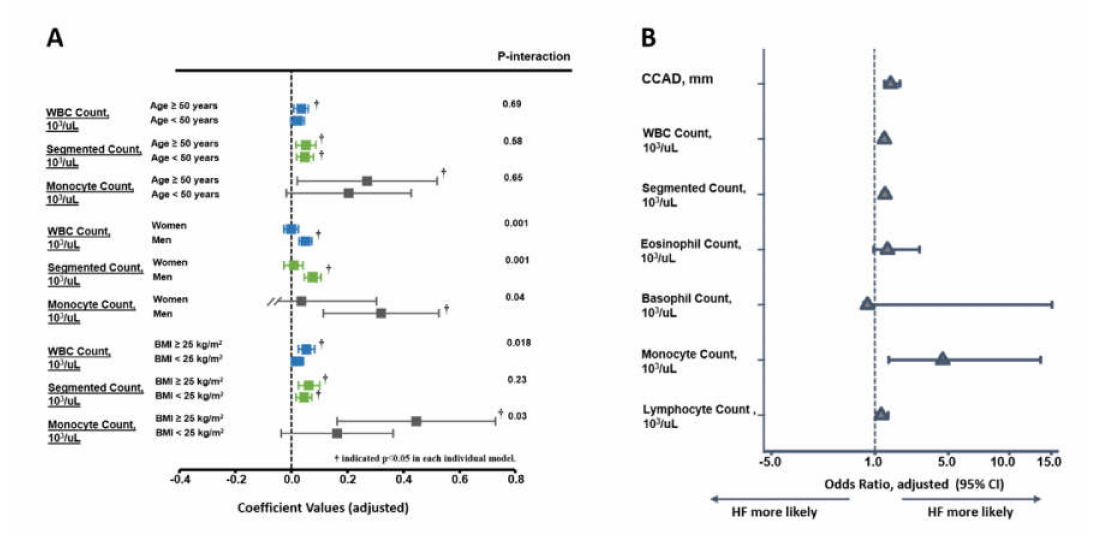
Figure 2. The associations between various leukocyte counts (including total WBC, segmented, monocyte, and lymphocyte counts) and common carotid artery diameter (CCAD) in the subgroup analysis (based on age ( ≥ , < 50 years), sex, and BMI ( ≥ , < 25 kg / m 2 ) categories) ( A ). The risks of HF admission based on CCAD and various leukocyte fractions after adjustment are presented as odds ratios and 95% confidence intervals (CIs) ( B